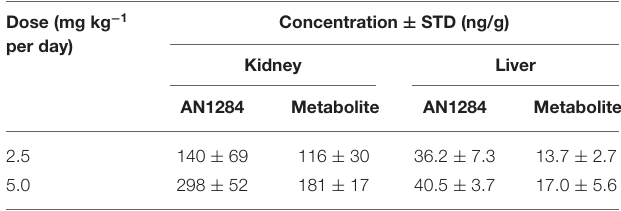
Concentration ± STD